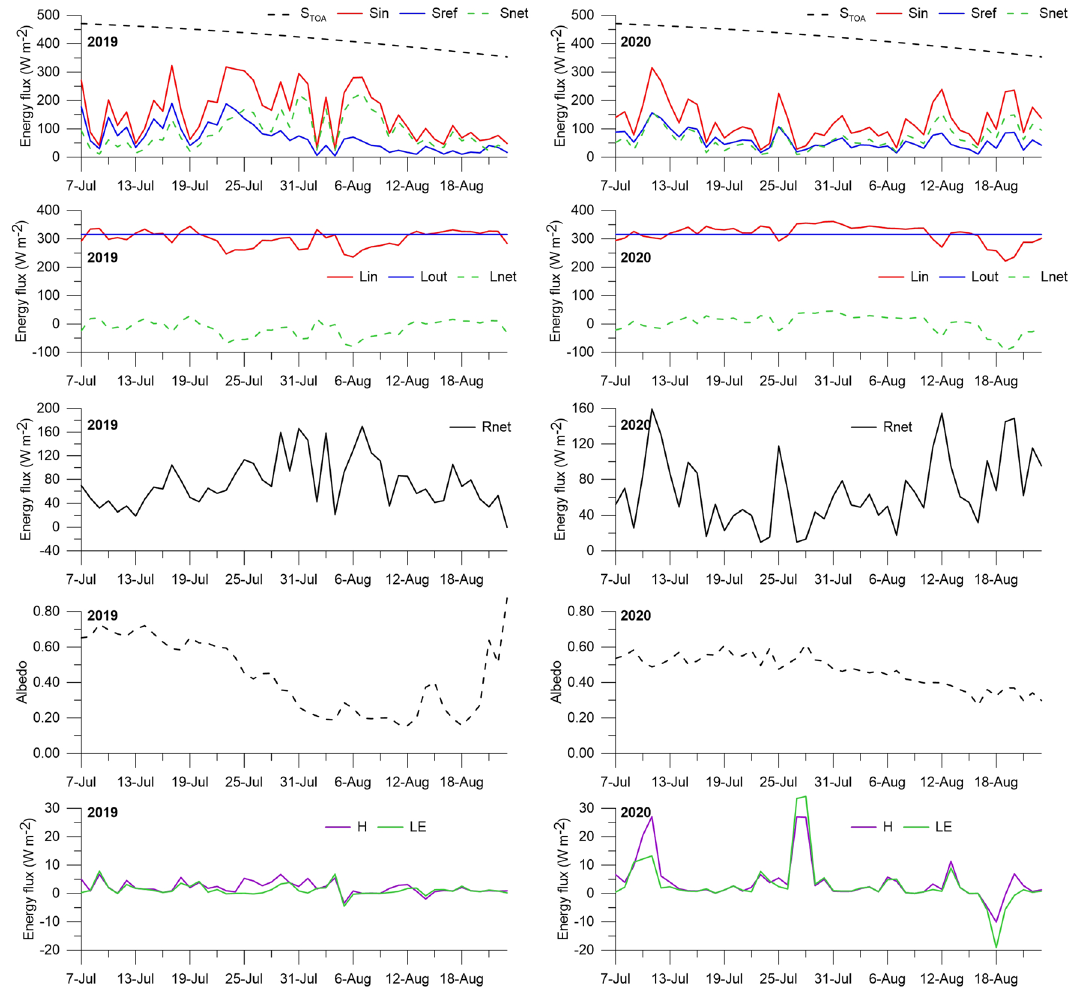
Figure 4. Mean daily values of radiation and turbulent energy fluxes and albedo during the 2019 and 2020 ablation seasons (for the period 7 July to 23 August): top of atmosphere radiation (S TOA ), incoming (S in ) and reflected (S ref ) shortwave radiation, incoming (L in ) and outgoing (L out ) longwave radiation, net radiation (R net ), sensible (H) and latent (LE) heat from that in 2019 (Fig. 4). If in July, the albedo fluctuated within the narrow range of 0.47–0.62 (on average 0.54), then in August, it had a pronounced decreasing trend from 0.48 to 0.30 (on average 0.39). During the study period, summer snowfalls were observed on 28 July and 19–20 August (small peaks on the curve). In general, the average albedo in the AWS1 area in July was 1.4–2 times higher than in August. Longwave radiation. The sensors of longwave radiation were installed only on the moraine (AWS2) to prevent the risk of losing them due to snow avalanches failing down from surrounding slopes to glacier surface. Since during both ablation seasons the glacier surface was melting (about 0 °C) the emitted longwave radiation flux was taken constant (316 W m −2 ) 11 . Both weather stations (AWS1 and AWS2) are located close to each other (300 m in distance and 30 m in altitude) within the same boundary layer, therefore we assumed the incoming longwave radiation measured off the ice (L in , AWS2) was corresponded to that on the glacier (AWS1). Compared to shortwave radiation (Fig. 4), L in had insignificant interannual and day-to-day variability and ranged from 236 to 344 W m −2 in 2019 (on average 301 W m −2 , standard deviation 28 W m −2 ) and from 222 to 361 W m −2 in 2020 (on average 319 W m −2 , standard deviation 31 W m −2 ). It changed slightly within the ablation season and was maximum in July 2020 (328 W m −2 ) and minimum in August 2019 (300 W m −2 ). However, the net longwave radiation in 2019 was slightly different from that in 2020. In 2019, it varied from − 80 to 29 W m −2 (average − 15 W m −2 ), while in 2020, it varied from − 94 to 46 W m −2 (on average 4 W m −2 ). That is, if in the 2019 observation period, the net longwave radiation was a sink of energy, then in 2020, on the contrary, the glacier surface received additional energy from the atmosphere. In 2019, the daily net longwave radiation was positive for 20 days (42% of the period), and in 2020, for 31 days (65%) due to increased cloudi- ness in 2020. The relationship between L in and cloudiness is confirmed by a good correlation between them (R 2 is 0.52 in 2019 and 0.56 in 2020, n = 48).